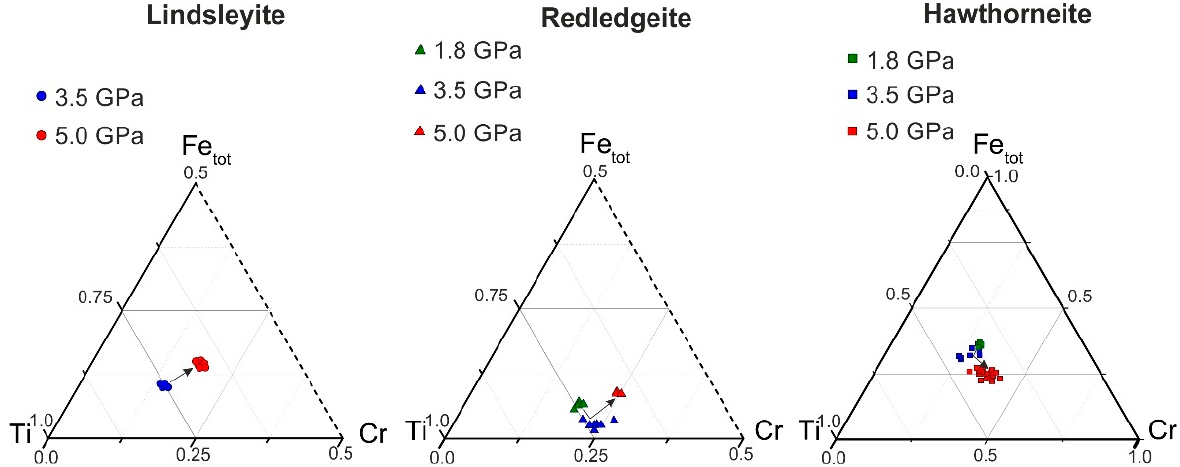
Figure 2. Ti–Fe–Cr diagram (apfu). The arrows indicate the displacement of points with increasing pressure.